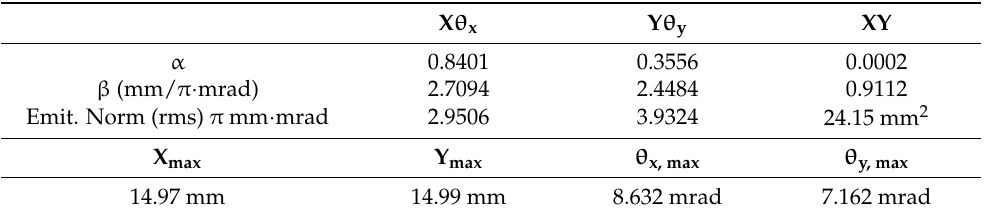
Table 1. ESS acceptance parameters. The parameters are defined in [8] and summarized here. X θ